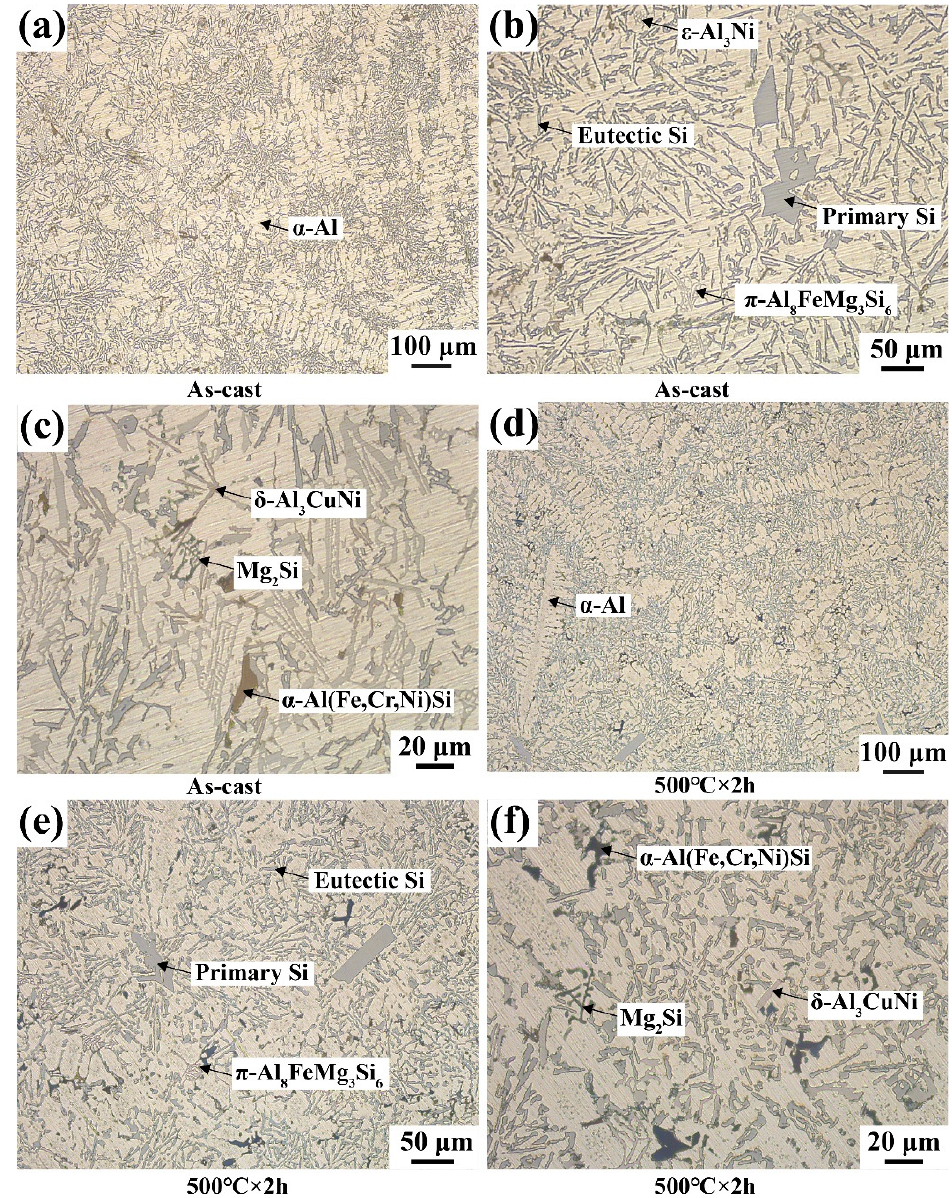
Figure 5. Optical micrographs of the alloys at different states: ( a – c ) as cast, ( d – f ) 500 ℃ for 2 h.